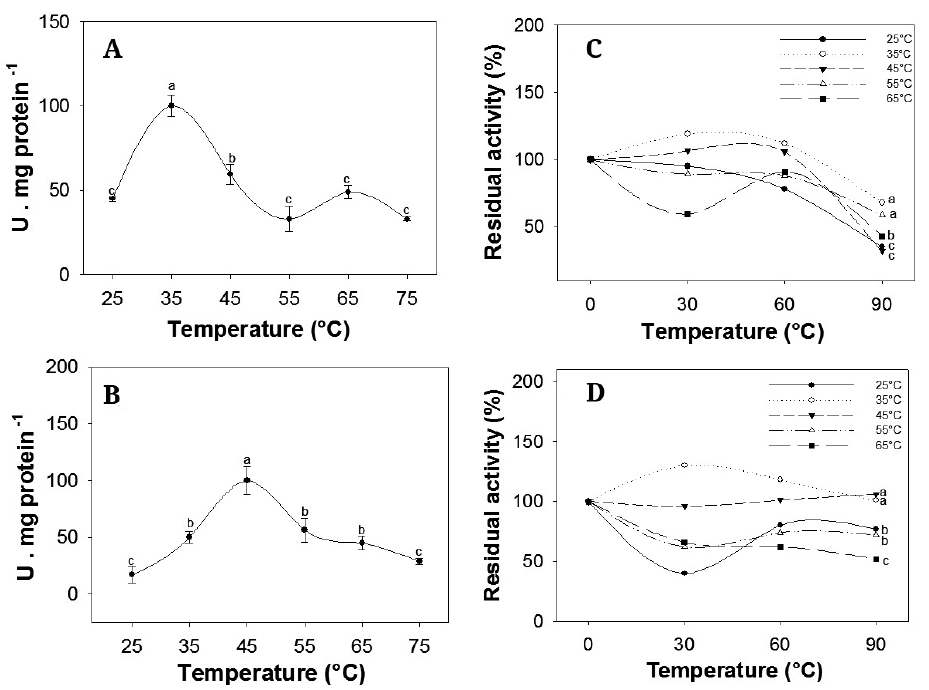
FIGURE 2 | Effect of temperature on digestive proteases of juvenile of short-tailed pipefish ( Microphis brachyurus ): A. optimum temperature of acidic proteases; B. thermal stability of acidic proteases; C. optimum temperature of alkaline proteases; and D. thermal stability of alkaline proteases (mean ± SD, n = 3). Mean values denoted with different letters are statistically different, p <